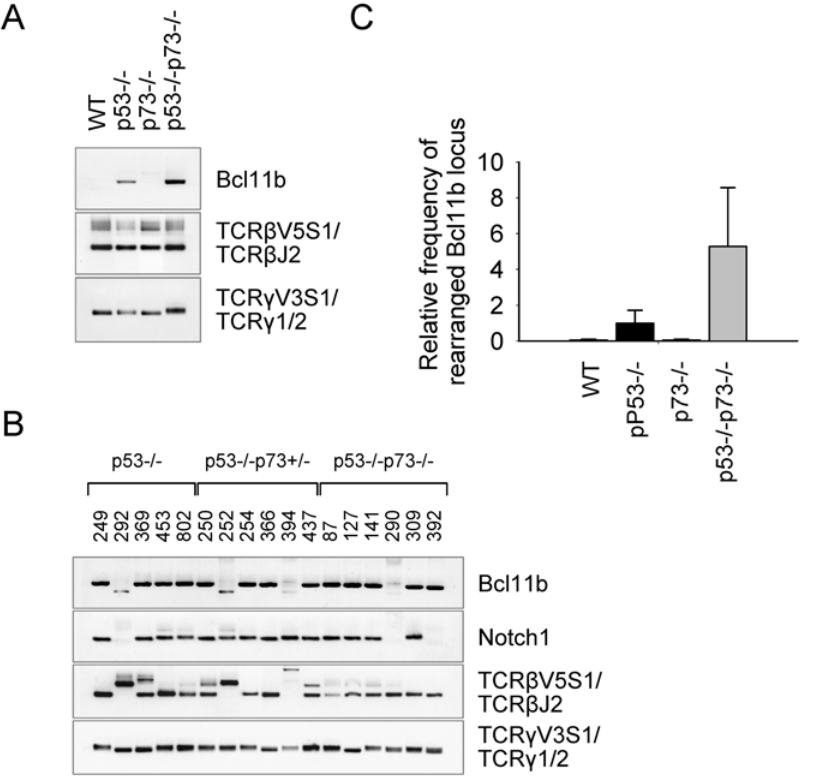
Figure 6. V(D)J recombination poses a risk for genomic instability in thymocytes deficient for p53 and p73. A, B. Genomyc PCR analysis of internal deletion at the Bcl11b and Notch1 loci in thymocytes from WT, p53 2 / 2 , p73 2 / 2 , and DKO mice ( A ), and in lymphomas derived from p53 2 / 2 , p53 2 / 2 p73 + / 2 and p53 2 / 2 p73 2 / 2 mice ( B ). Consistent data were obtained from three mice of each genotype. TCR b and TCR c gene rearrangements are shown for controls. Tumor numbers are indicated. C. Relative frequency of rearranged Bcl11b gene in thymocytes from WT, p53 2 / 2 , p73 2 / 2 , and DKO mice. The results are representative of six mice of each genotype. The error bars represent the standard